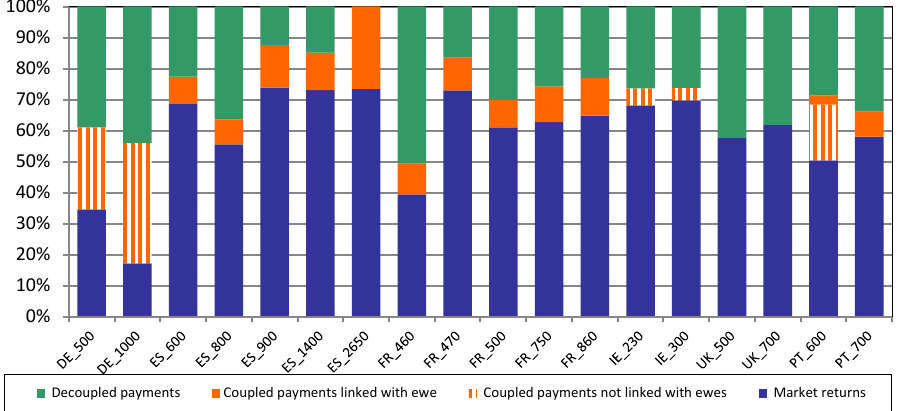
Figure 3. Composition of whole farm returns (%). Source: model results.